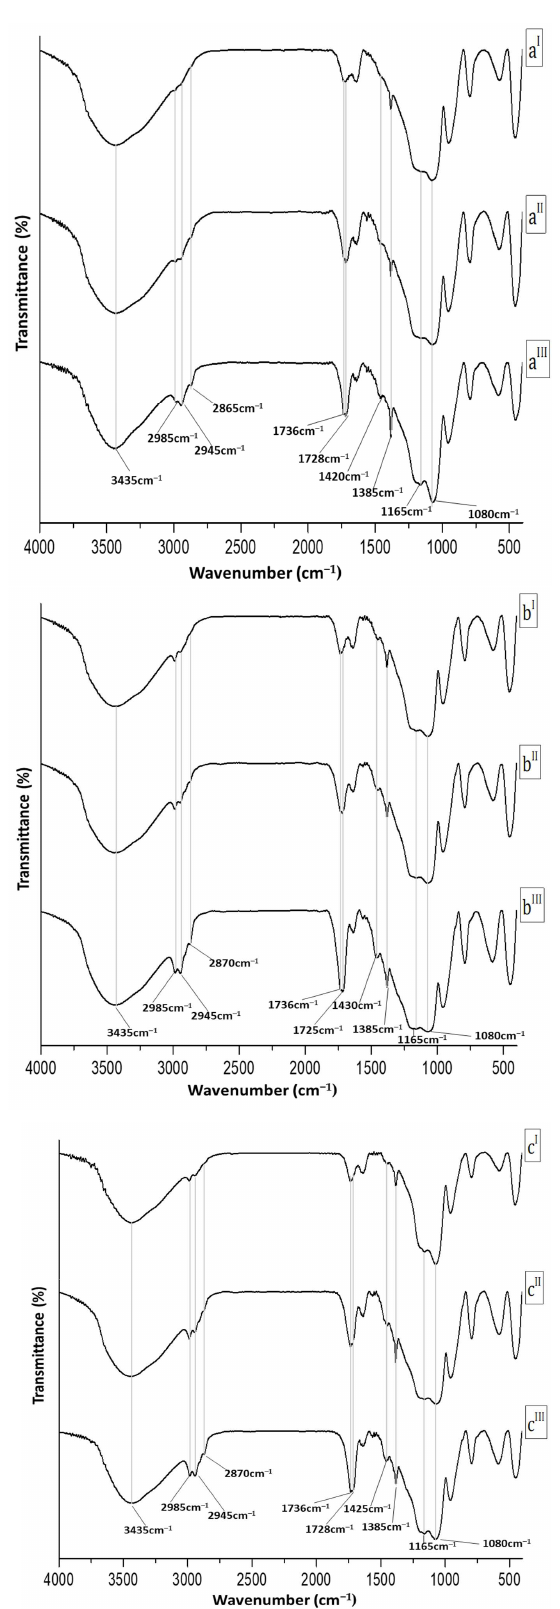
Figure 2. FTIR spectra of ( a I ) SC5P6; ( a II ) SC5P12; ( a III ) SC5P24; ( b I ) SC10P6; ( b II ) SC10P12; ( b III ) SC10P24; ( c I ) SC15P6; ( c II ) SC15P12; ( c III ) SC15P24.